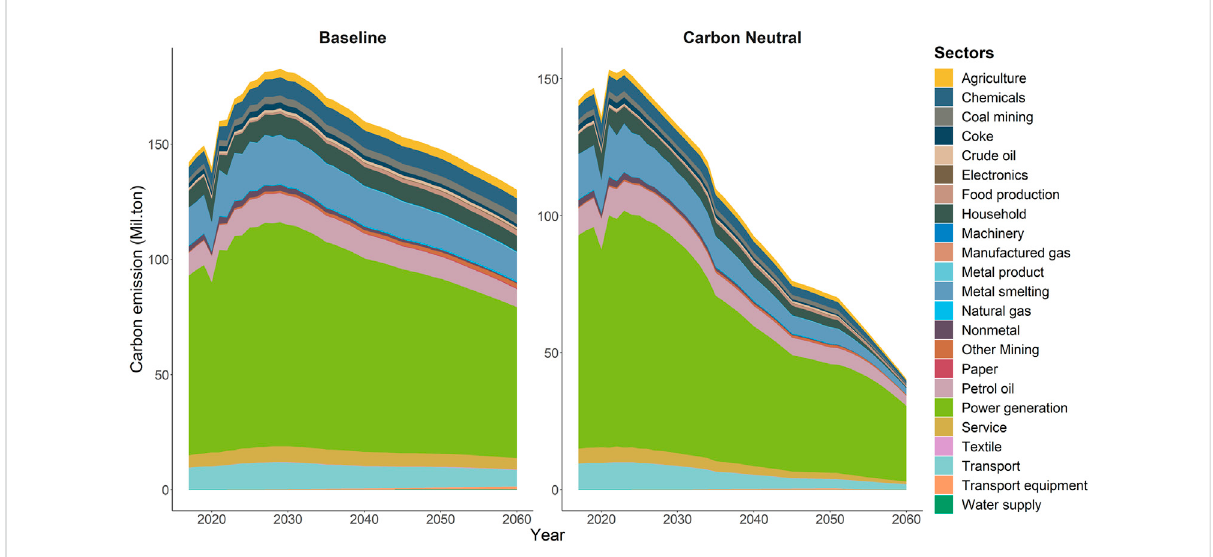
FIGURE 4 Carbon emissions in baseline scenario and carbon neutral scenario by sector in